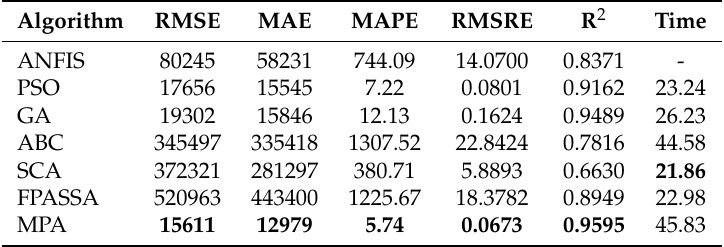
Table 3. Results of the